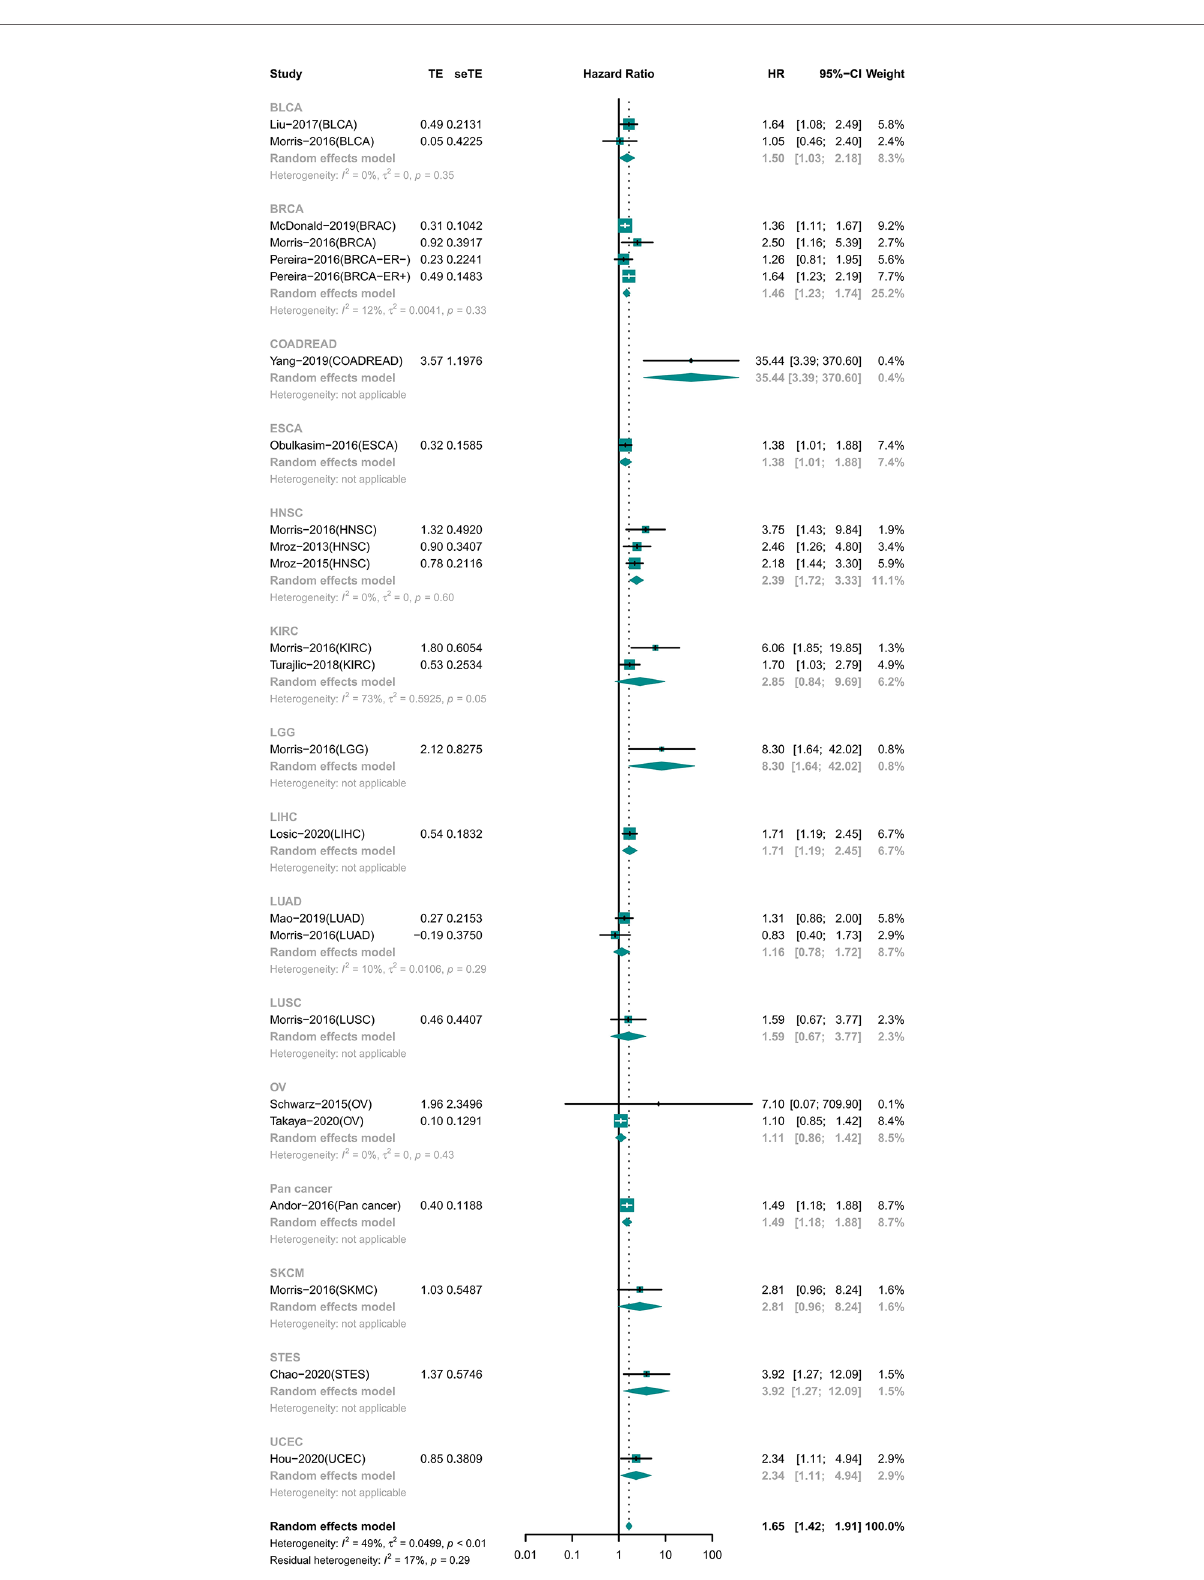
Frontiers in Oncology |